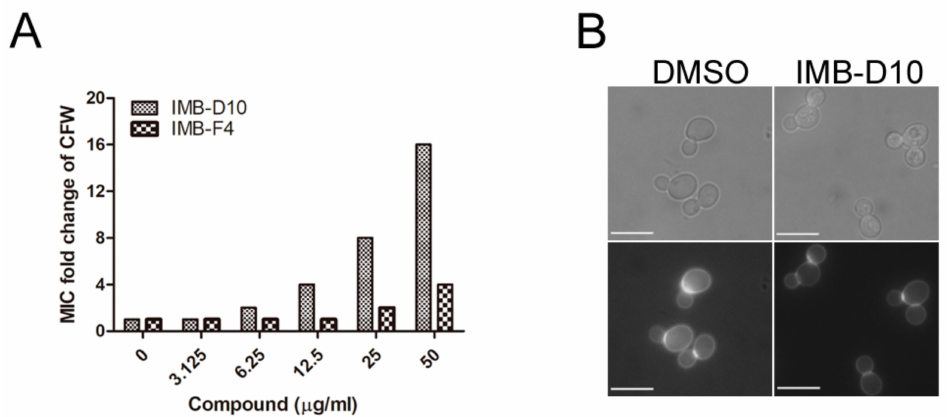
Figure 3. The e ff ect of IMB-D10 and IMB-F4 on the antifungal activity of CFW and cell division. Fresh WT yeast cells were diluted to 10 4 CFU / ml in YPD (1% yeast extract, 2% peptone, and 2%